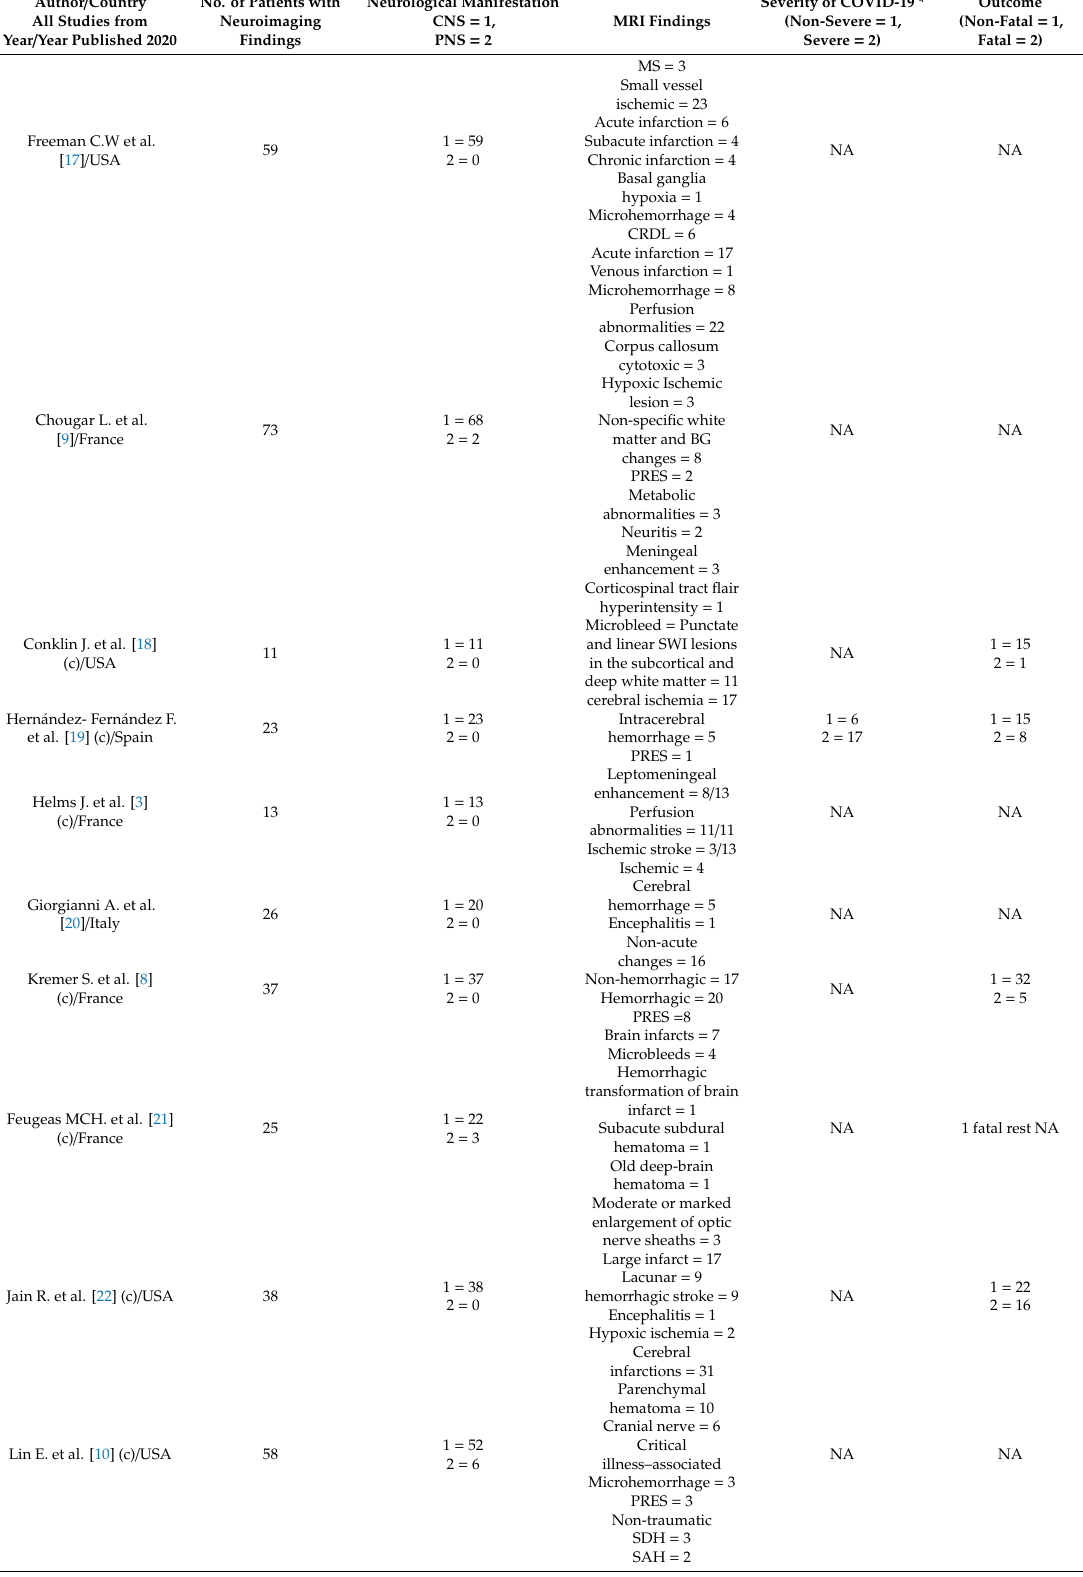
Studies with grouped data with detailed MRI findings and associated neurological manifestations with severity and outcomes for